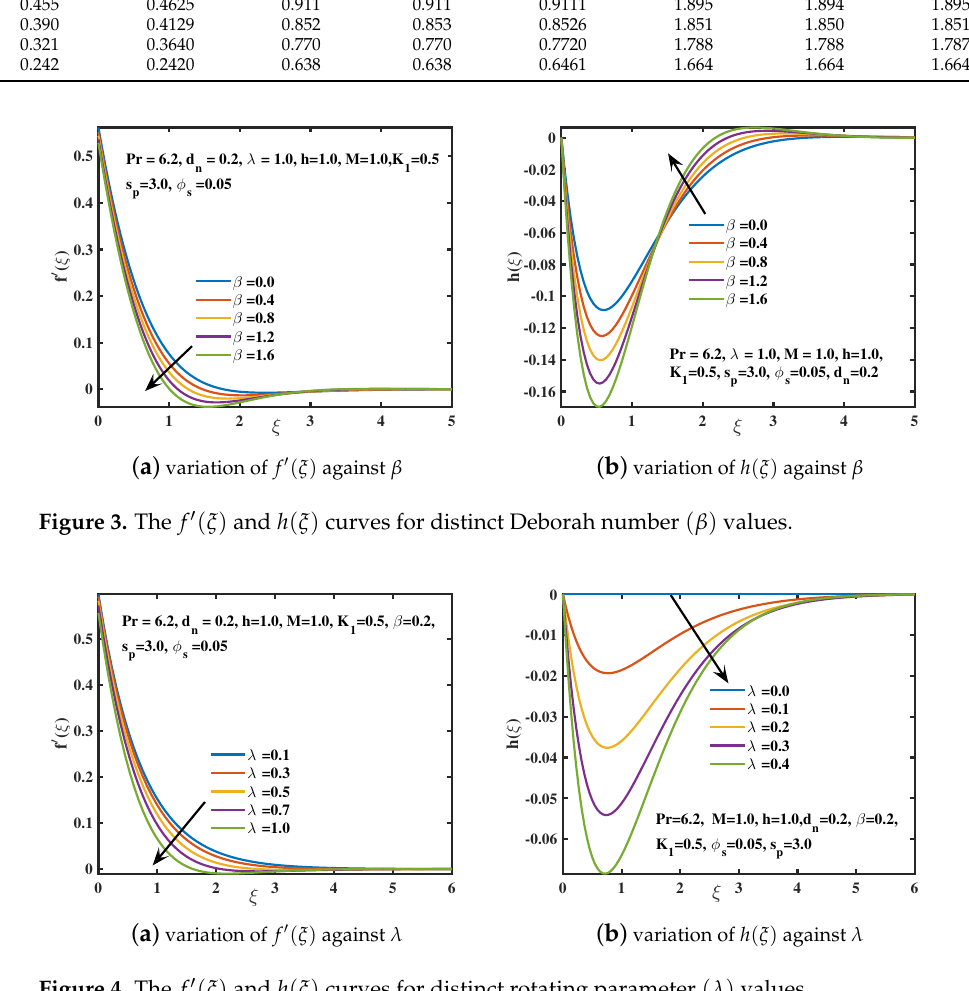
Figure 4. The f (cid:48) ( ξ ) and h ( ξ ) curves for distinct rotating parameter ( λ ) values.